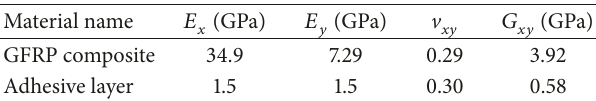
Table 1: Mechanical properties of pultruded GFRP composite and adhesive